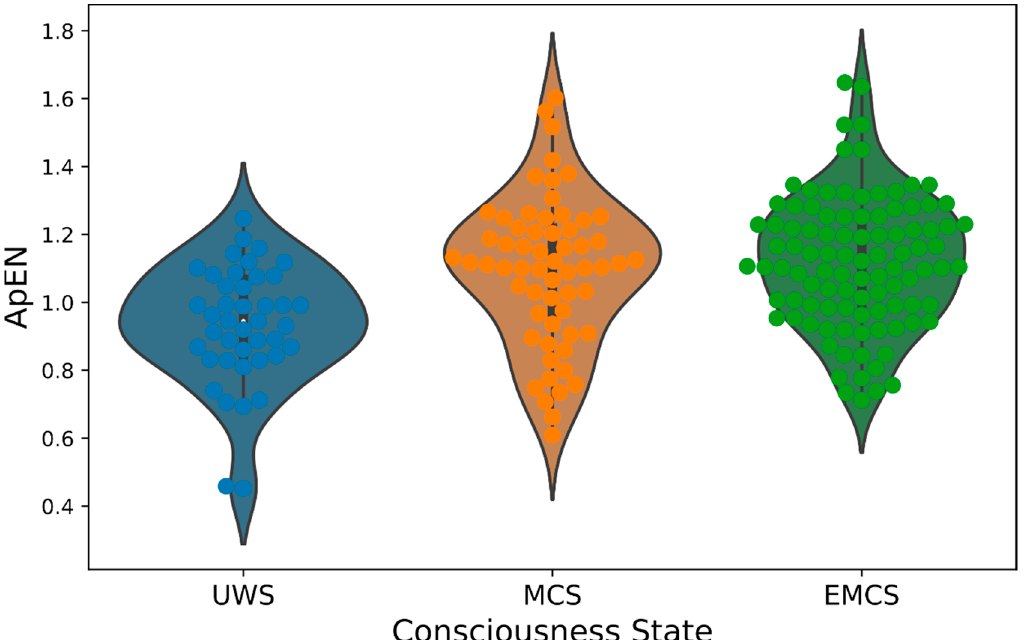
Figure 1. Approximate Entropy (ApEN) of respiration rate (RR) intervals across consciousness states. Legend. ApEN: Approximate Entropy; UWS: Unresponsive Wakefulness Syndrome; MCS: Minimally Consciousness State; EMCS: Emergence from MCS. Table 2. Generalized linear model with ApEN as response